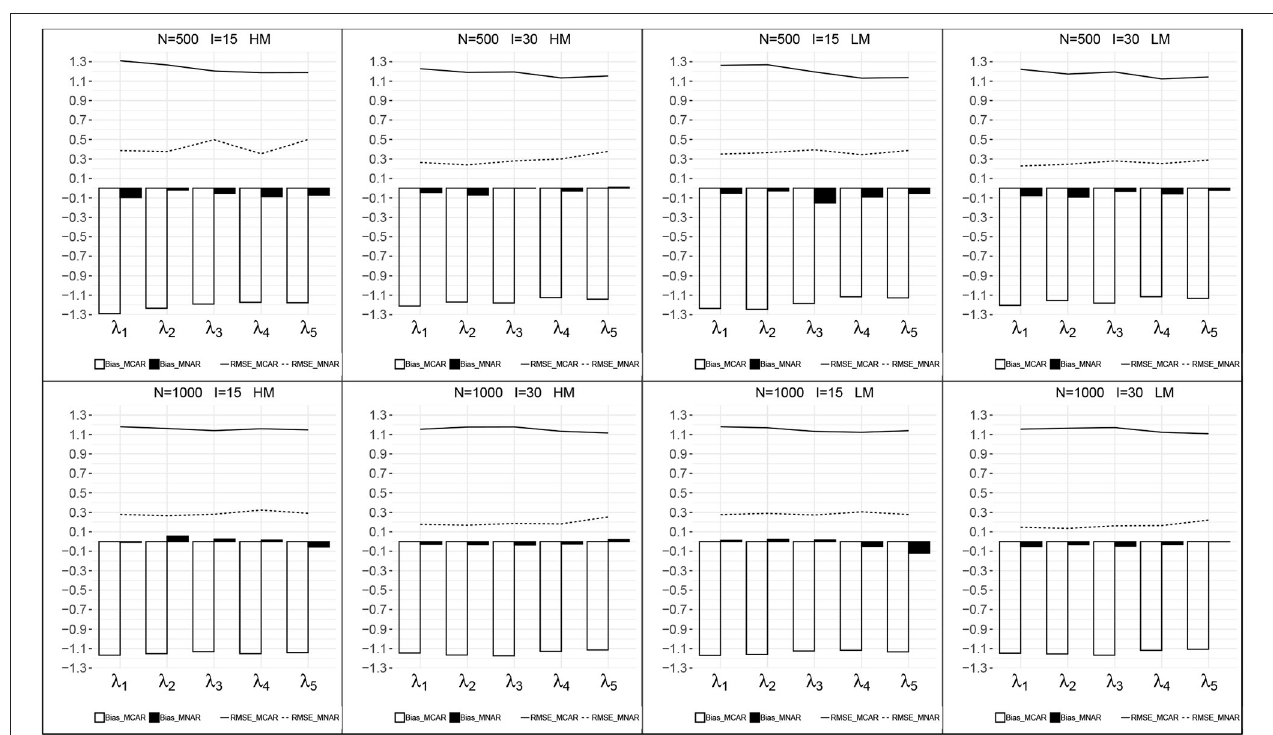
FIGURE 3 | Recovery of the attribute intercept parameters. HM, high missingness; LM, low